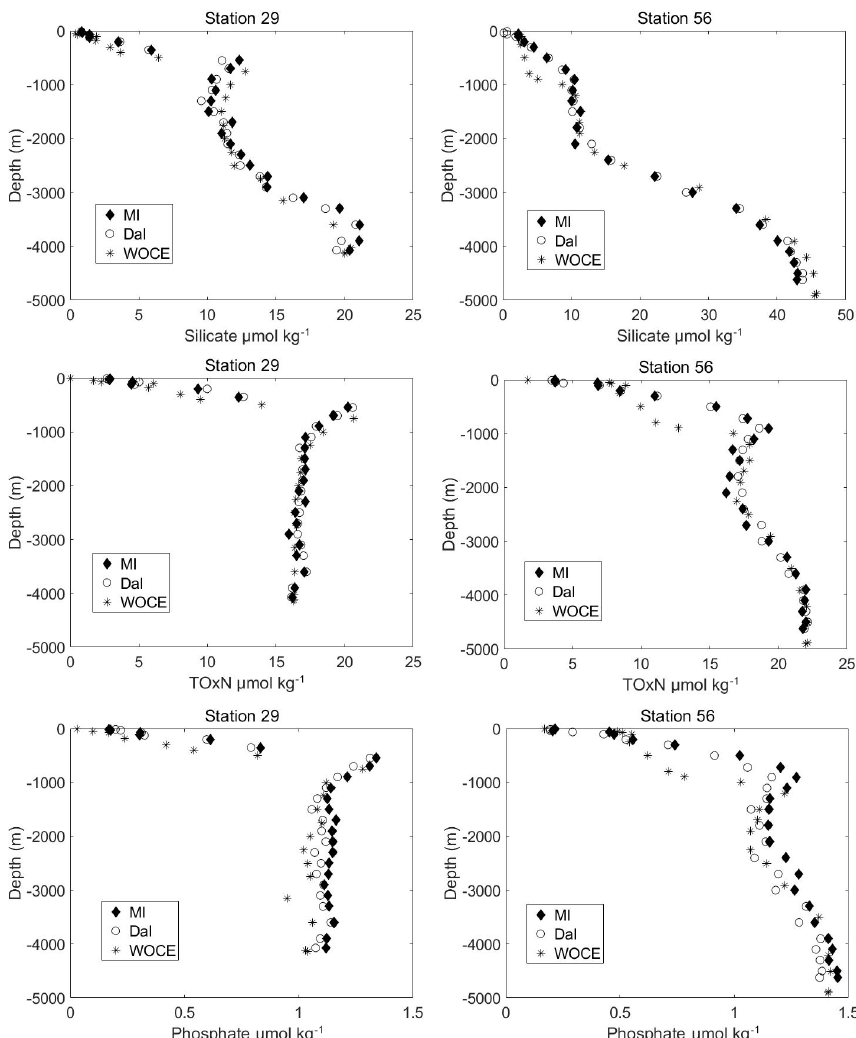
Figure 2. Vertical profiles of TOxN, silicate and phosphate (in µmolkg − 1 from the MI (Marine Institute), Dal (Dalhousie University) and WOCE (World Ocean Circulation Experiment) data sets. Only stations 29 and 56 are included here; all other stations compared are in the Supplement. Profiles are in µmolkg − 1 since WOCE data were reported in µmolkg − 1 rather than µmolL − 1